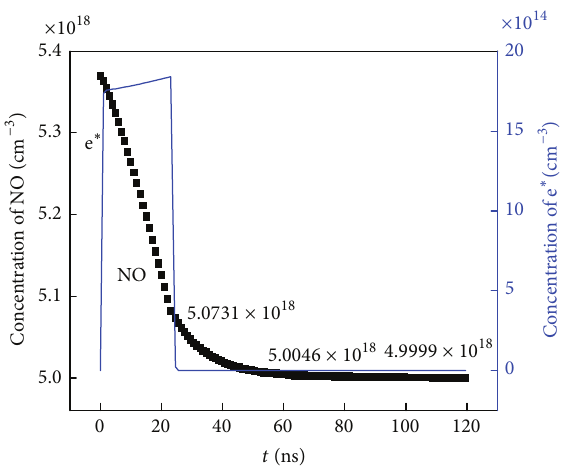
Figure 7: Concentration variance of NO molecules and electrons versus time. The concentration of NO is 5.37 × 10 18 /cm 3 at 0 ns, 5.0731 × 10 18 /cm 3 at 24.5 ns, 5.0046 × 10 18 /cm 3 at 60ns, and 4.9999 × 10 18 /cm 3 at 120ns.